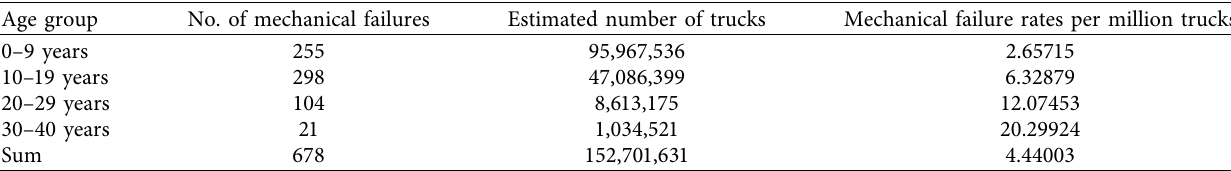
Table 5: Rates of truck-involved crashes occurring due to mechanical